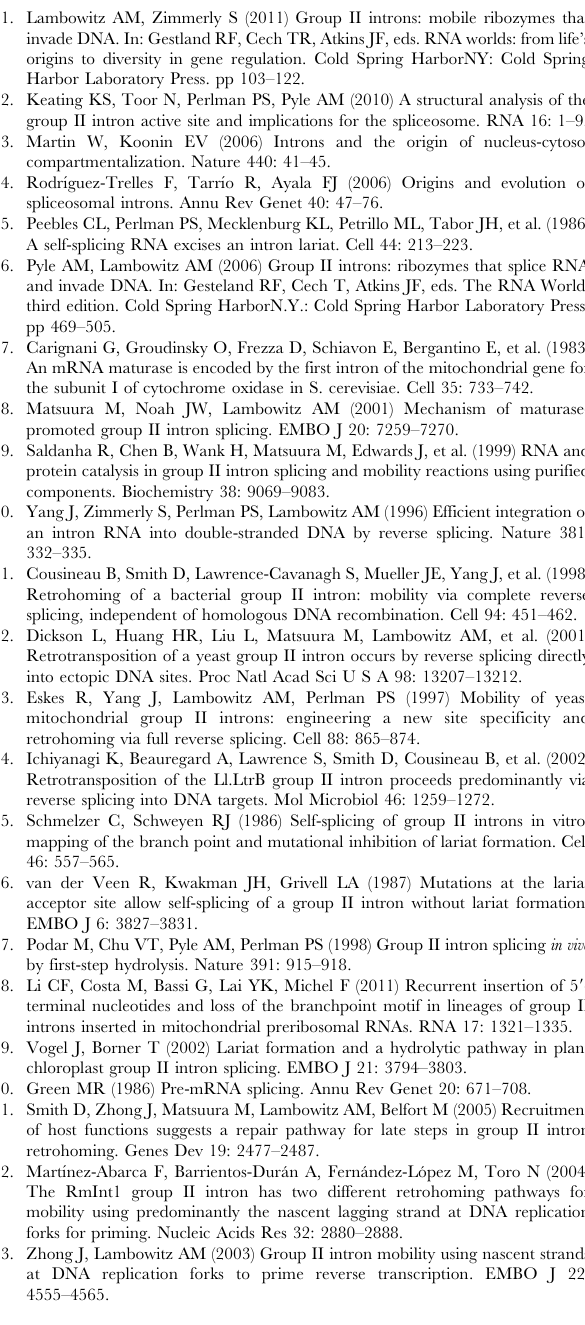
Table S1 Summary of experiments comparing retrohoming efficiencies of linear and lariat Ll.LtrB intron RNAs in wild-type and mutant D. melanogaster embryos. Retrohoming assays using lariat and linear RNPs were done in D. melanogaster precellular blastoderm embryos, as described in Figure 2A and Materials and Methods. After incubating the embryos for 1 h at 30 u C, nucleic acids were extracted and transformed into E. coli HMS174(DE3) for plating assays of retrohoming efficiency. WT, wild type. a Retrohoming efficiency calculated as (Tet R + Amp R )/Amp R colo- nies. b Retrohoming efficiency relative to wild-type w 1118 or Or-R assayed in